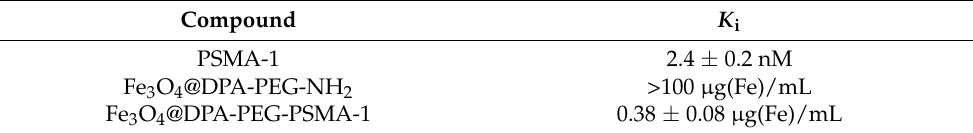
Table 2. PSMA inhibitory